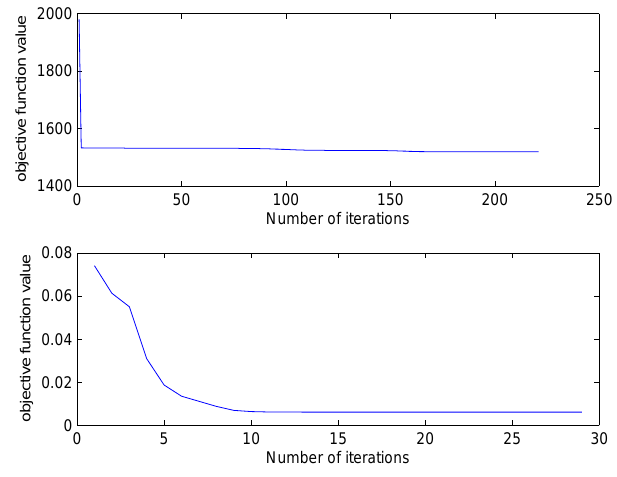
Figure 3. Comparison of the iterative process.